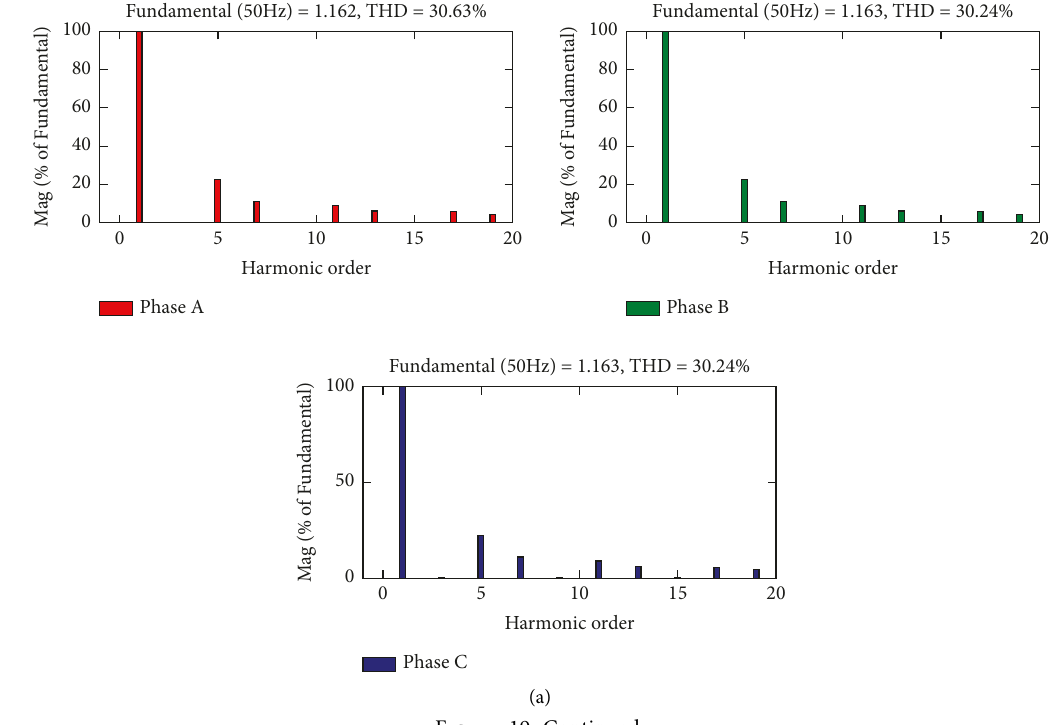
Figure 18: Simulation results proposed MMPIFC boost converter operated PV-SHAPF under variable load. (a) Phase A voltage of TPTL inverter. (b) Phase B voltage of TPTL inverter. (c) Phase C voltage of TPTL inverter. (d) Source current before compensation. (e) Injected current. (f) Source current after